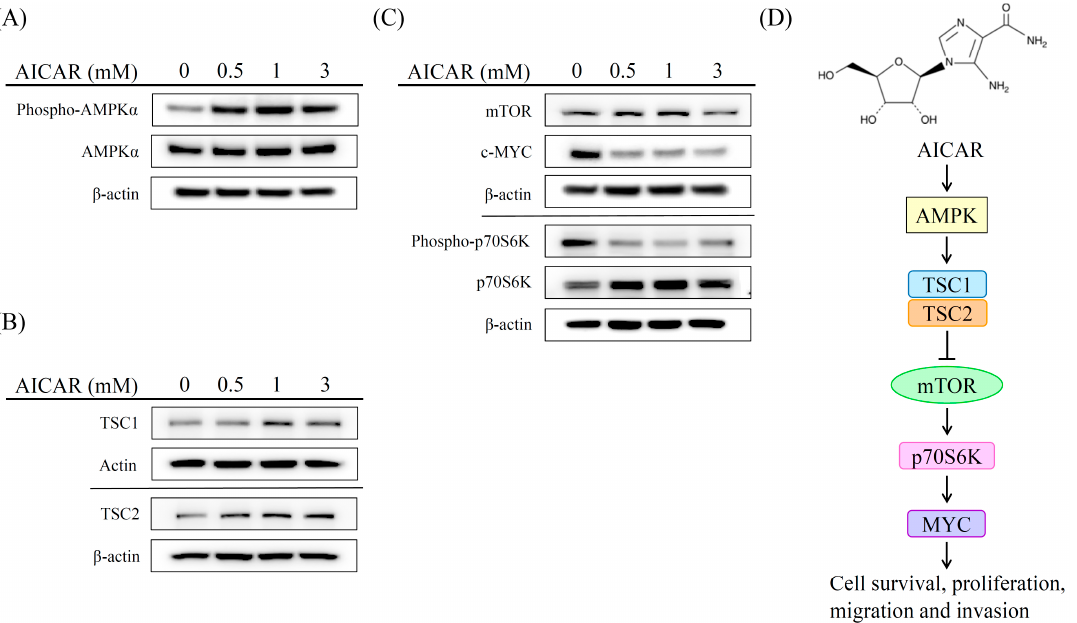
Figure 6. Effect of AICAR on the AMPK/mTOR-dependent pathway in 22Rv1 prostate cancer cells. Cells were treated with different concentrations of AICAR for 2 h. The expression of ( A ) phospho-AMPK, AMPK, ( B ) TSC1 and TSC2 was examined by western blot. Cells were treated with different concentrations of AICAR for 6 h. ( C ) The expression of mTOR, cMYC, phosphor-p70S6K and p70S6K was determined by western blot. Actin was used as a loading control in western blot. The western blotting results are representative of results obtained in three separate experiments. ( D ) Proposed mechanism of the anticancer effects induced by AICAR in 22Rv1 prostate cancer cells.